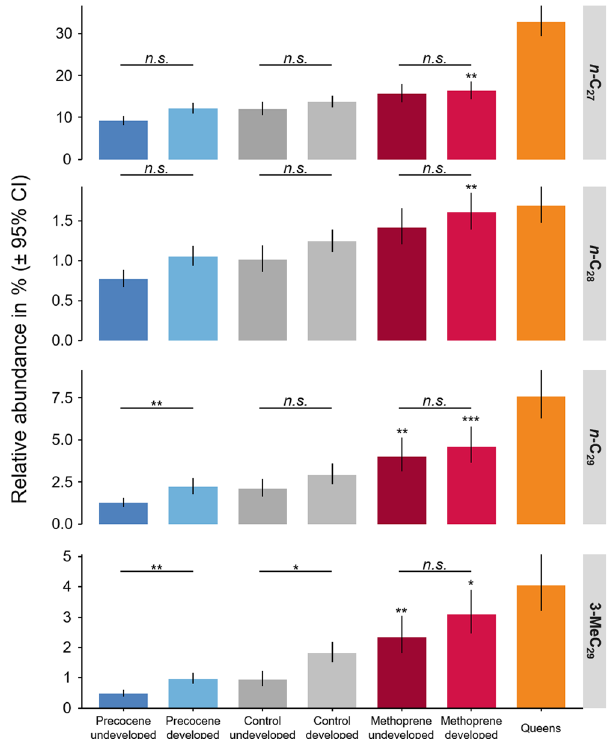
Figure 3. Juvenile hormone regulates known queen signals in the common wasp. Treatment of workers with the JH analog methoprene or the JH inhibitor precocene-I enhances or suppresses the production of four known sterility-inducing hydrocarbon queen pheromones (bars and whiskers = mean relative abundances and 95% confidence intervals calculated on log transformed relative abundance and then backtransformed to the original scale, asterisks above bars indicate the significance of contrasts with their respective control, whereas the asterisks above each pair of bars indicate differences in abundance between workers with or without developed ovaries of a given group; significance levels are based on linear mixed models on Aitchison transformed abundances, using Benjamini & Yekutieli 82 FDR p value correction: * p < 0.05, ** p < 0.01, *** p <